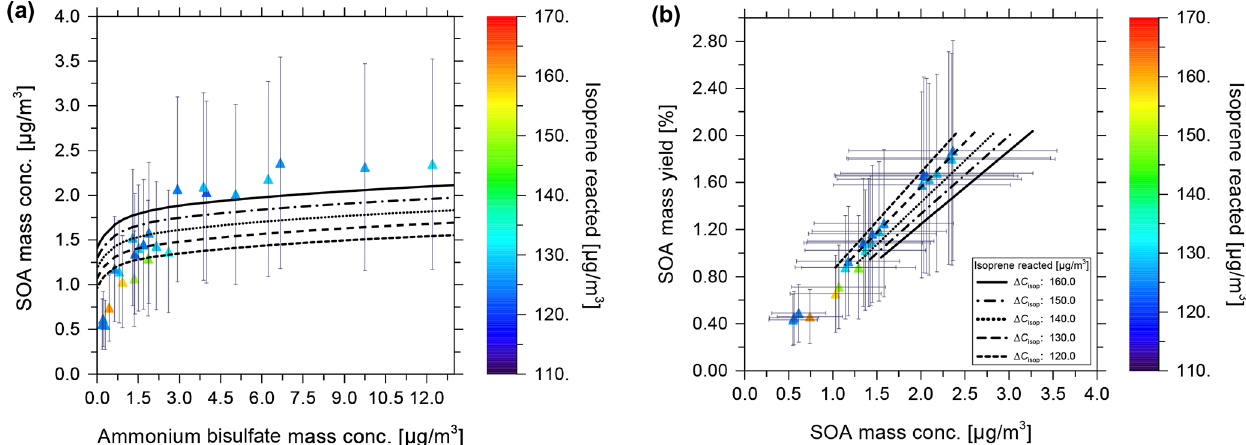
Figure 6. Comparison of CLOUD chamber data and gas–particle partitioning model calculations for isoprene SOA at varying inorganic seed concentrations. Experimental conditions are + 10 ◦ C at 85% RH, with ammonium bisulfate seed particles. (a) Measured and calculated SOA mass concentration vs. ammonium bisulfate concentration, where the solid triangles show the continuous flow data coloured according to the levels of [ISOPRCT] in the chamber (Fuchs, 2017). The black curves show the model predictions at different levels of isoprene reacted indicated in the figure key in panel (b) . (b) Measured and predicted SOA mass yield vs. SOA mass concentrations for the same range of ammonium bisulfate concentrations as in panel (a)